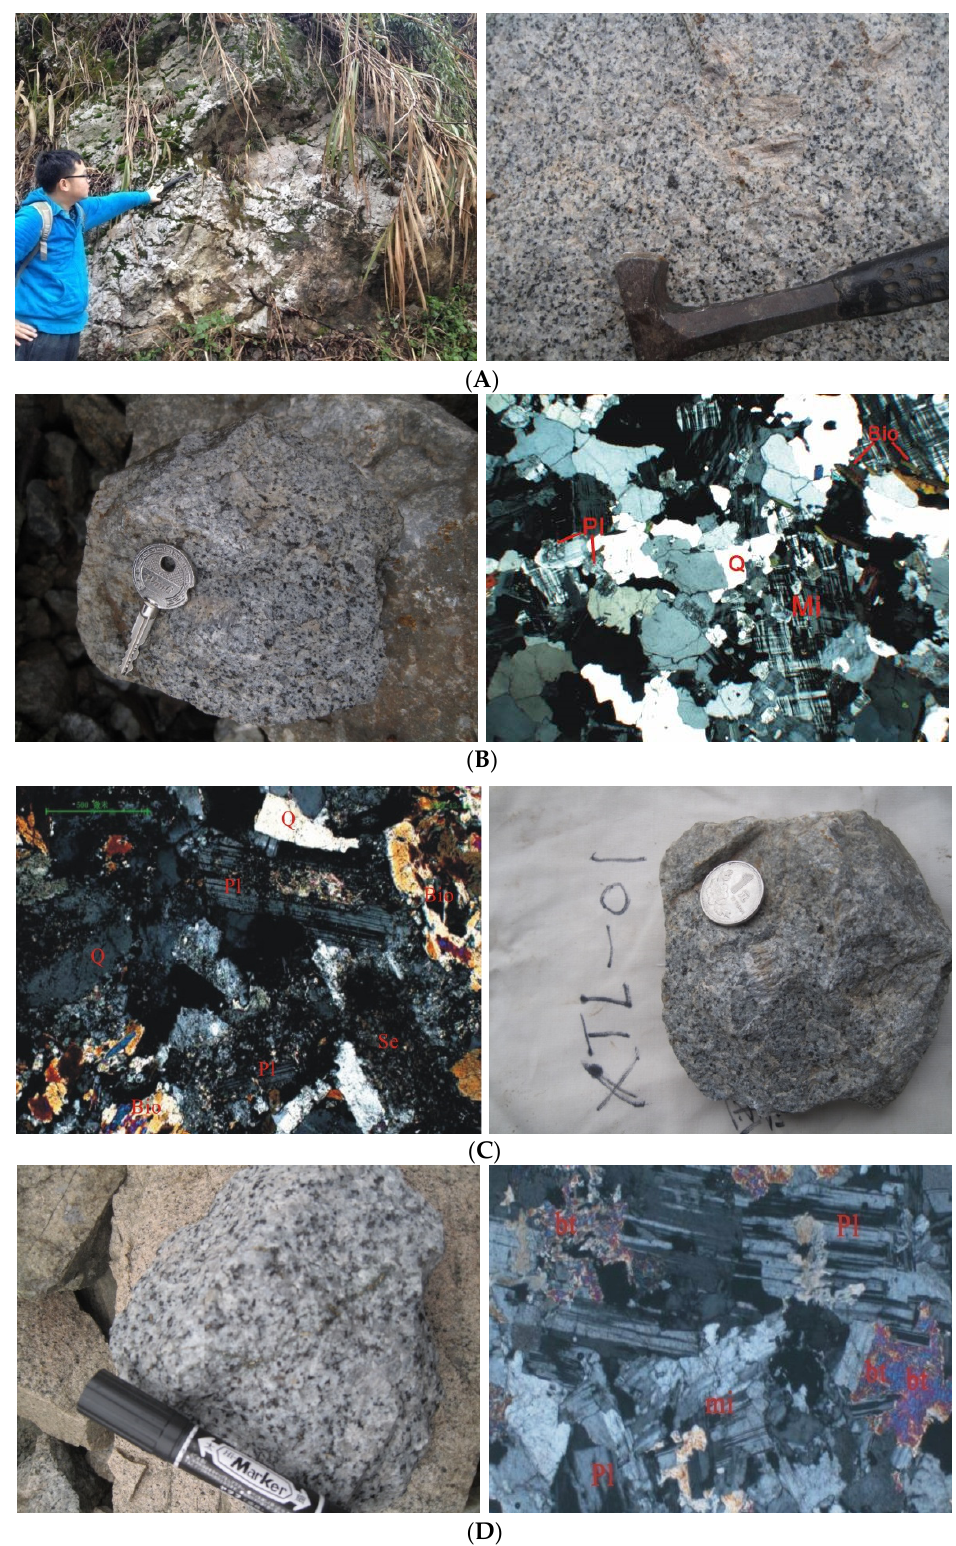
Figure 4. Field, macroscopic, and microscopic features of Xintianling granite. ( A ) Photos of granite outcrops in the wild; ( B ) Field hand specimen of granite porphyry and its microscopic characteristics (5 × 10 orthogonal polarized light); ( C ) Field hand specimen of granite porphyry and its microscopic characteristics (5 × 10 orthogonal polarized light); ( D ): Field hand specimens and microscopic features of pyritized biotite granite (5 × 10 orthogonal polarized light).